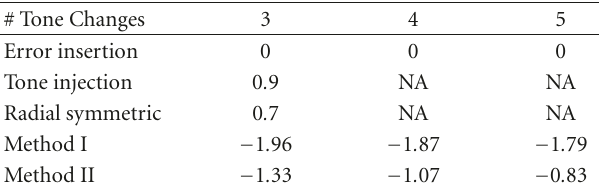
Table 1: Overall maximum average power increase for 64 tones OFDM system using 16-ary QAM